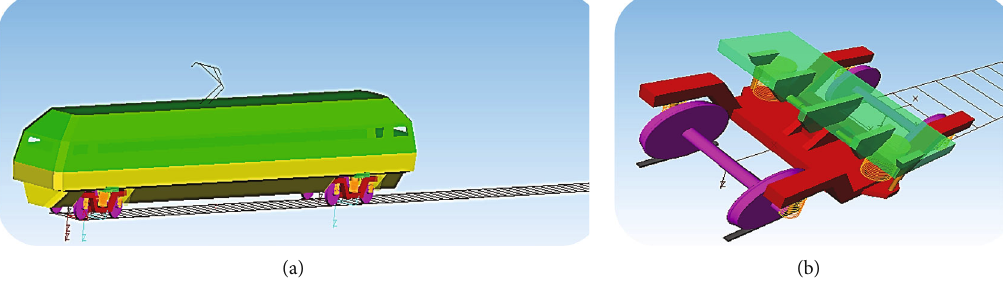
Figure 4: SIMPACK model; (a) vehicle and (b)